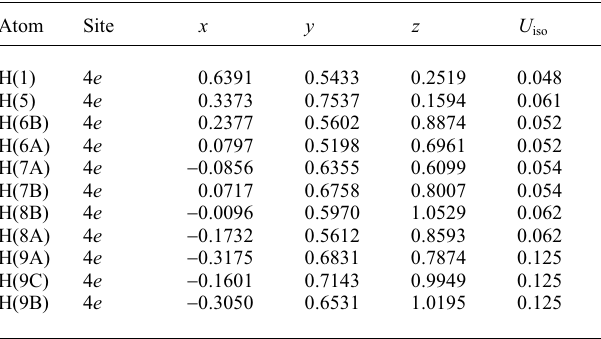
Table 2. Atomic coordinates and displacement parameters (in Å 2 )